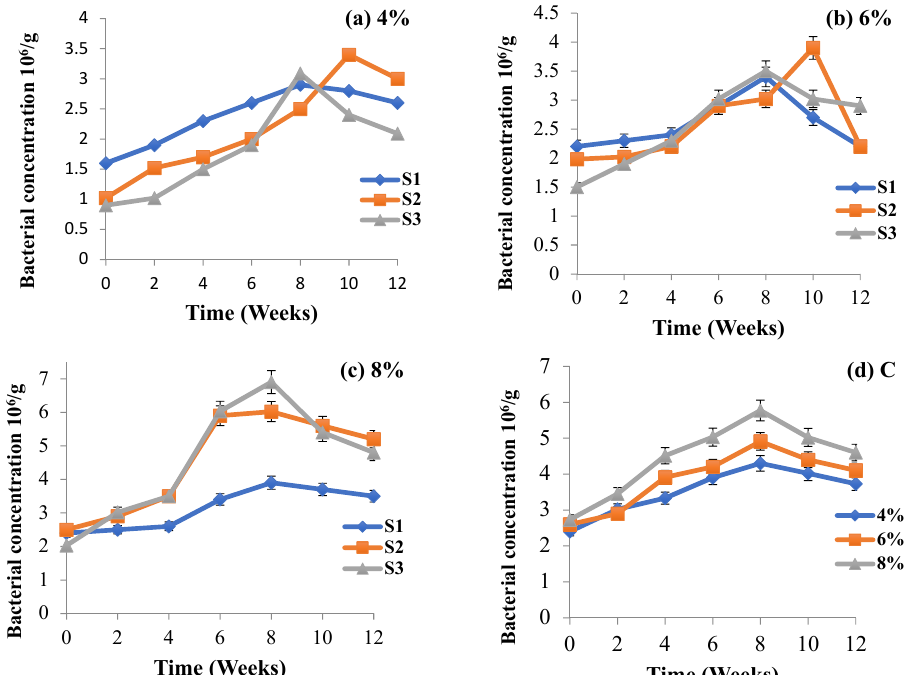
Figure 1. Evolution of bacterial growth of the three strains isolated and their consortium as function of the time at different inoculum doses (4% ( a ), 6% ( b ), and 8% ( c )). S1: Strain 1; S2: Strain 2; S3: Strain 3; ( d ) C: Consortium.